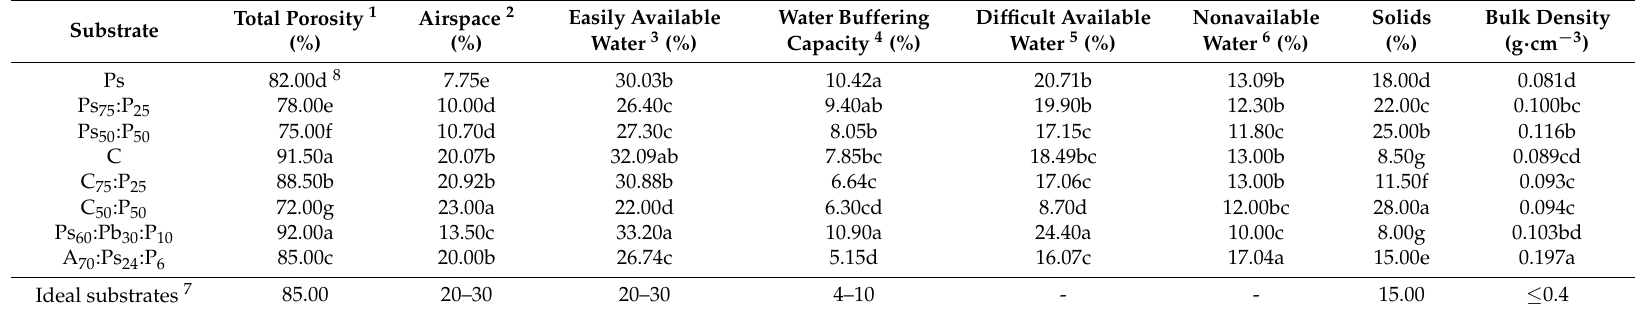
Table 4. Physical properties of the substrates. Values are the means of three replications ( n = 3). Easily Available Water Buffering Total Porosity 1 Airspace 2 Substrate Water 3 (%) Capacity 4 (%) (%) (%)